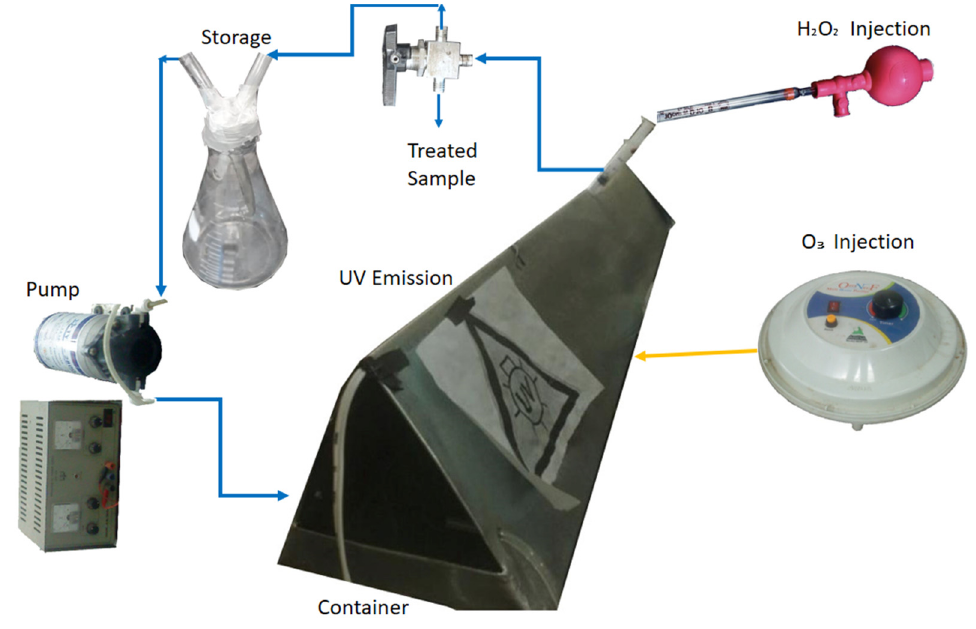
Figure 1. The disinfecting system at the experimental scale.